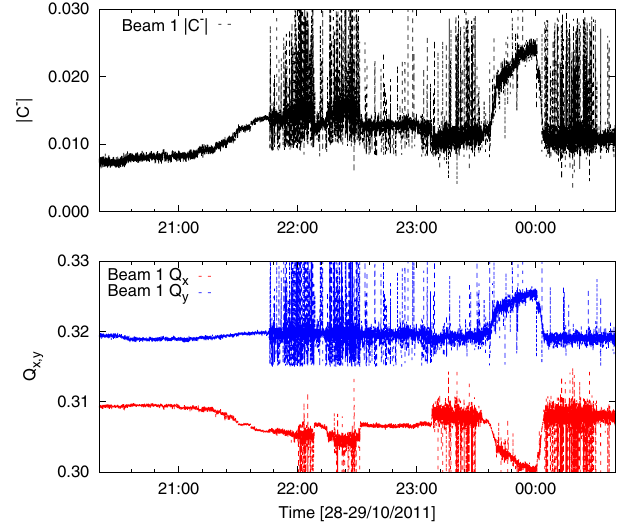
FIG. 2. An example of raw coupling (top) and tune (bottom) data recorded by the LHC BBQ for beam 1, plotted versus